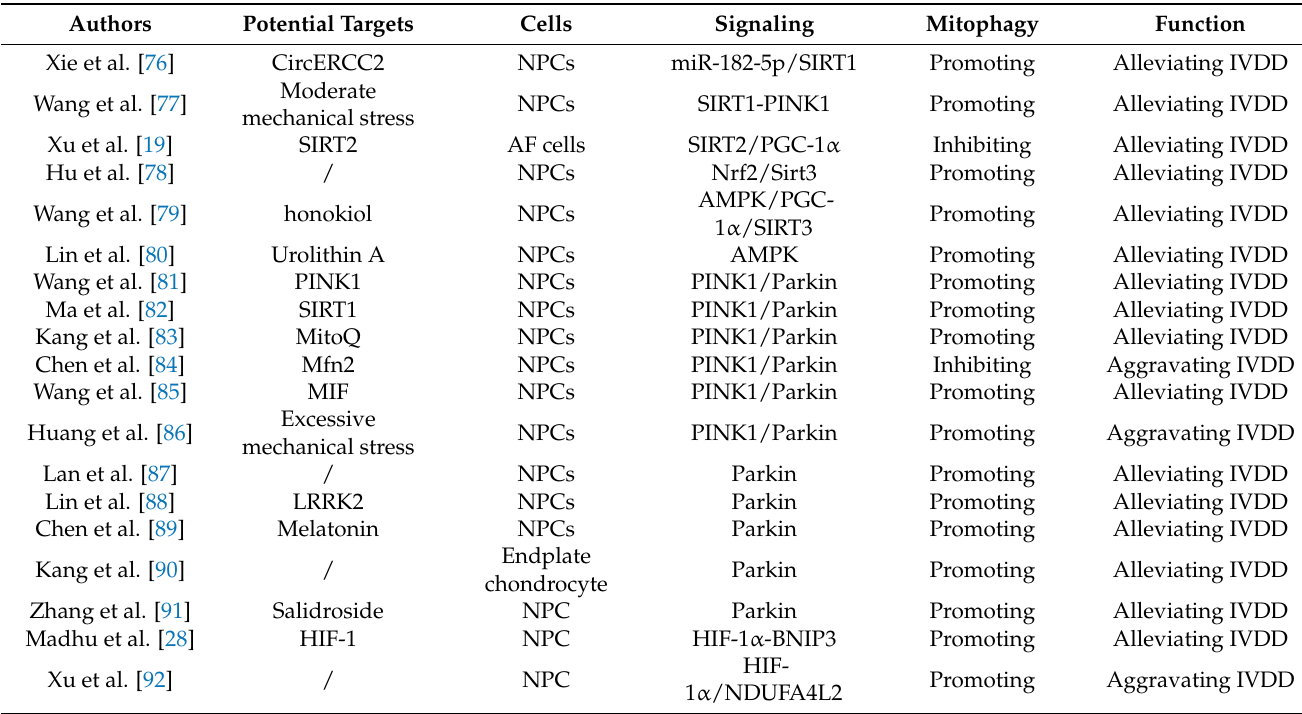
Table 1. Mitophagy in